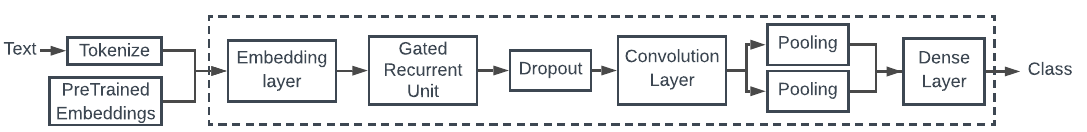
Figure 1. A Convolutional Neural Network.